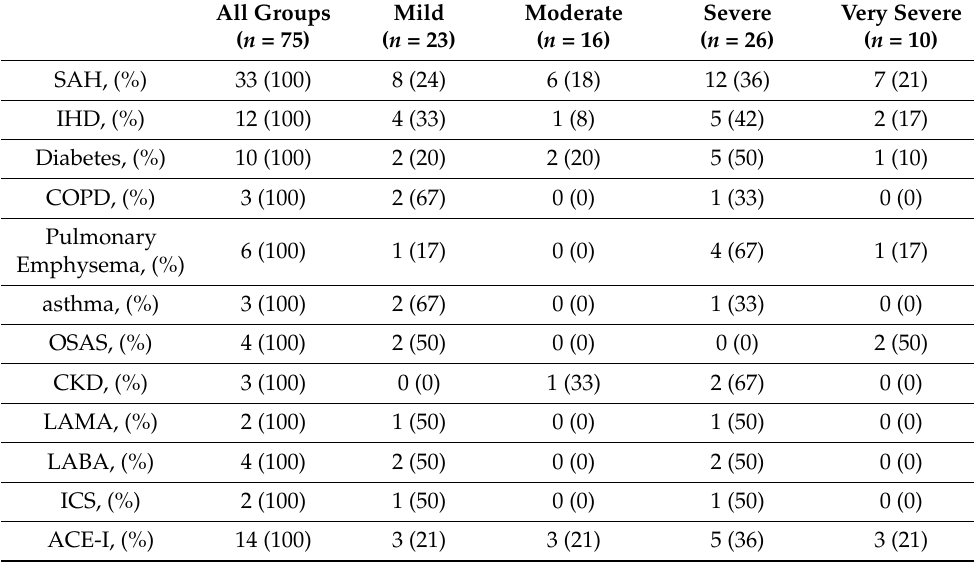
Table 2. Subjects’ comorbidities and chronic therapies.